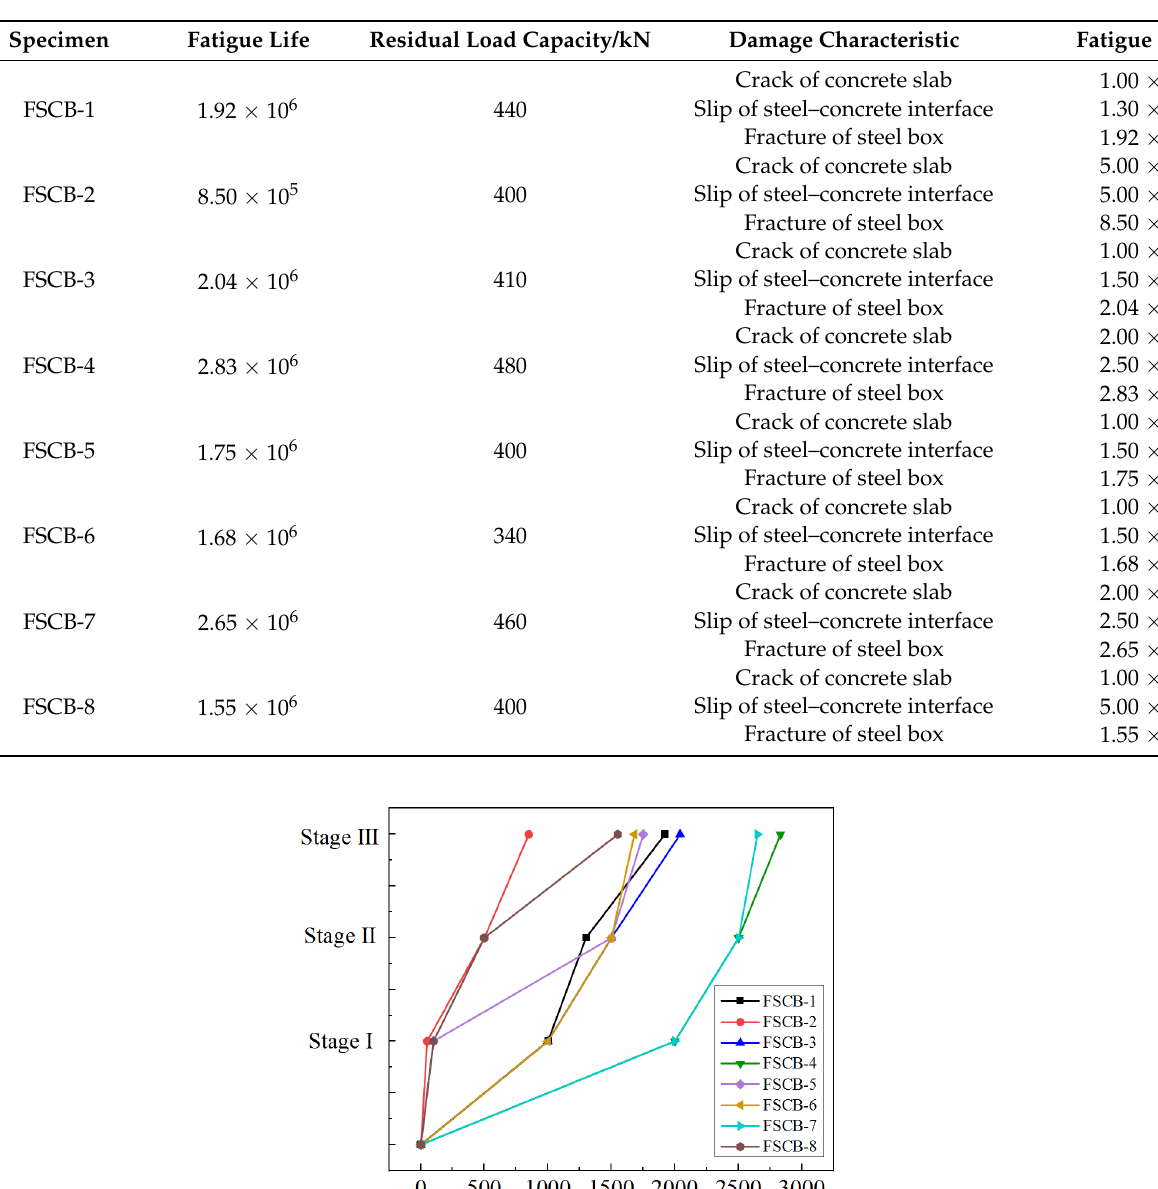
Table 5. Test results of FSCB-1 to FSCB-8.